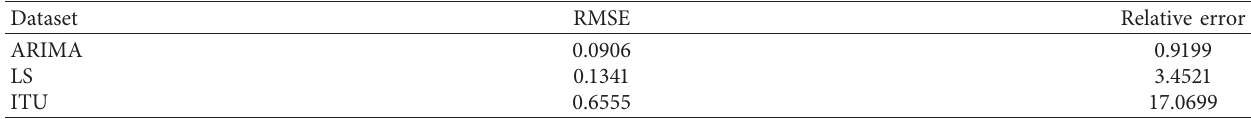
) , and (c) “data1” 2 . 3